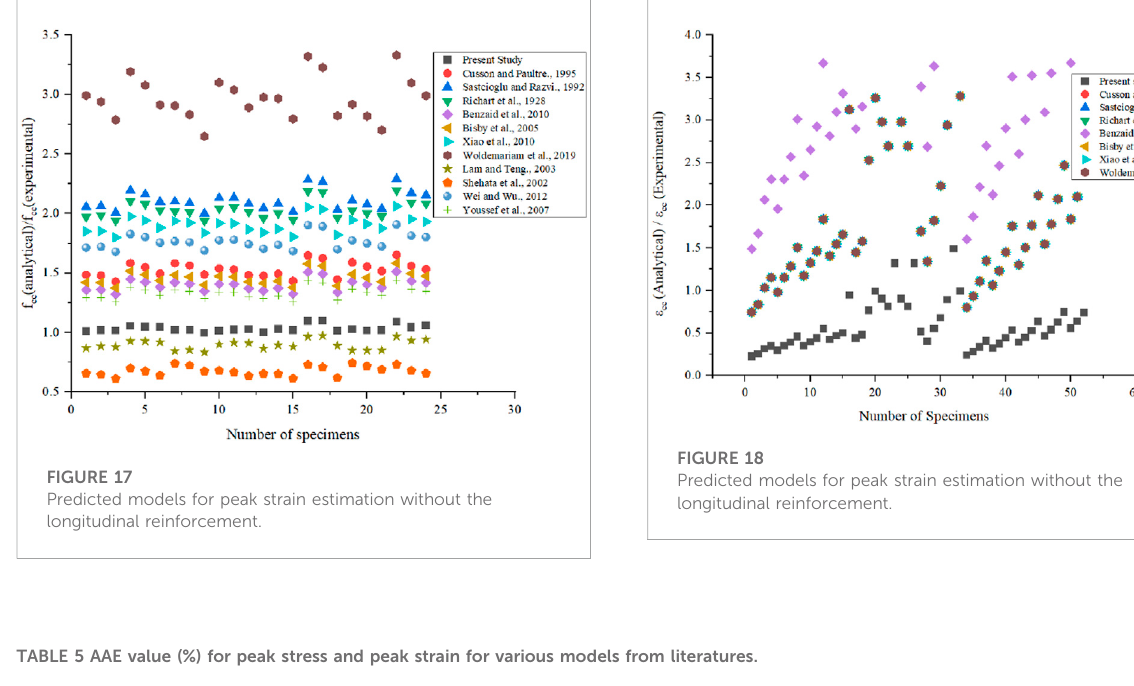
TABLE 5 AAE value (%) for peak stress and peak strain for various models from literatures. Source Stress Strain With long. Reinfor Without long. Reinfor With long. Reinfor Without long.